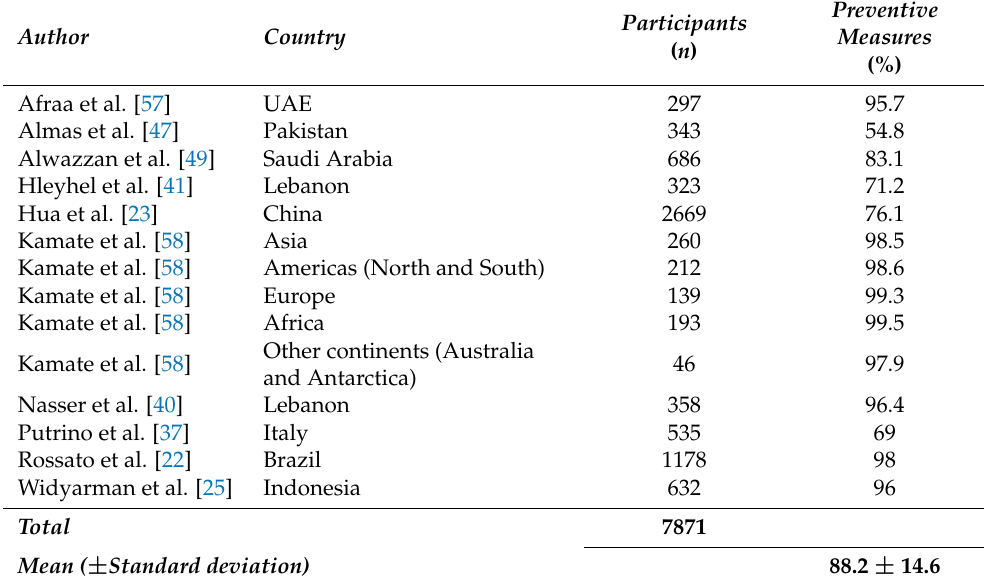
Table 5. Preventive measures